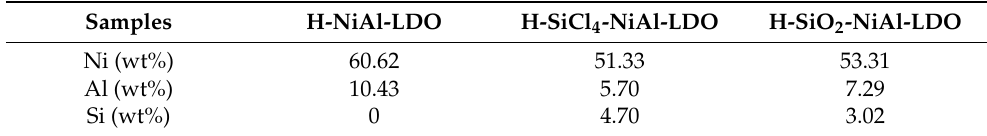
Table 3. Elemental analysis of the prepared catalysts.